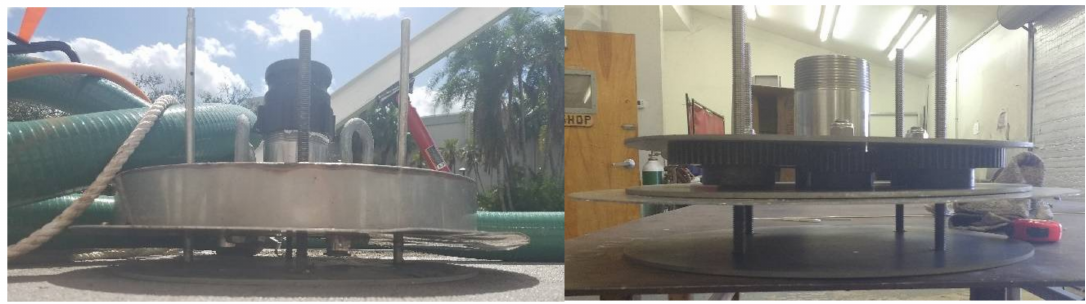
Figure 2. Variable area suction head (with and without gearbox cover, shown left to right ).